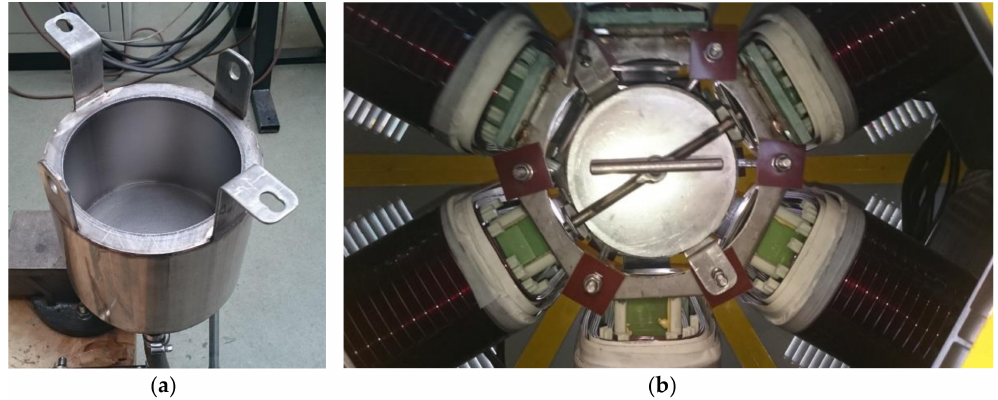
Figure 6. Batch working chamber for EMM: ( a ) Empty, open chamber; ( b ) Closed chamber in working position inside EMM.